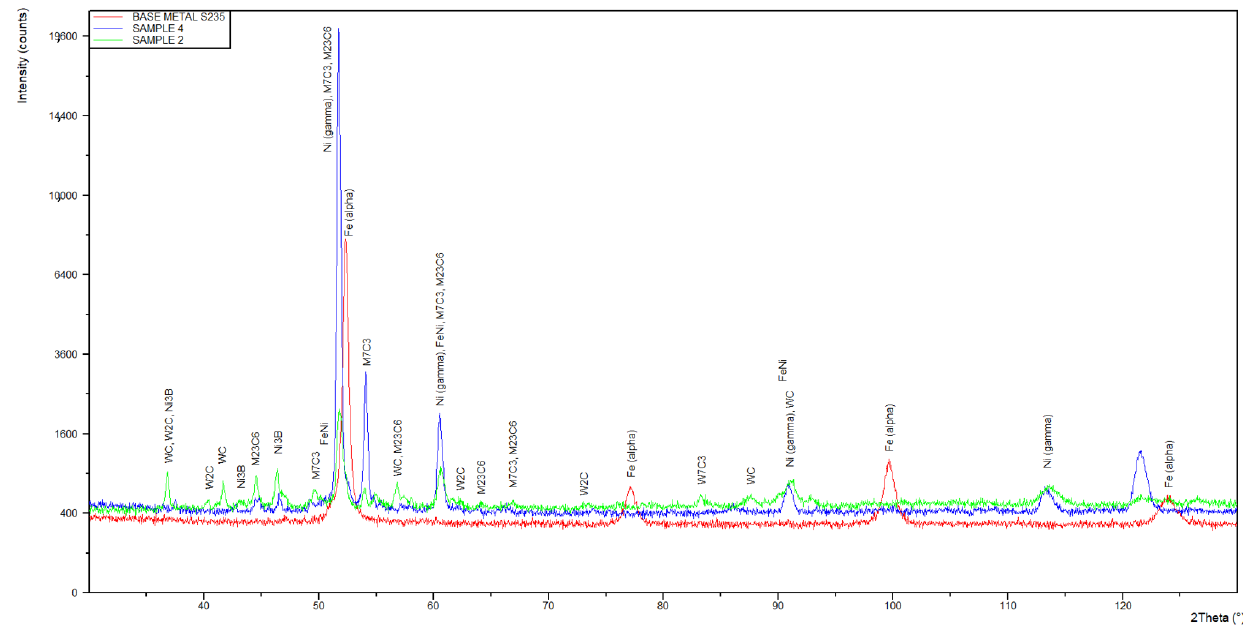
Figure 10. XRD patterns of the comparative coatings produced by laser cladding of experimental composite NiCrBSi/WC + W 2 C powder. Table 4. Summary of quantitative EDS analysis on the cross-section of the clad layers produced by laser cladding of experimental composite NiCrBSi/WC + W 2 C powder with different processing parameters, Table 2, Figure